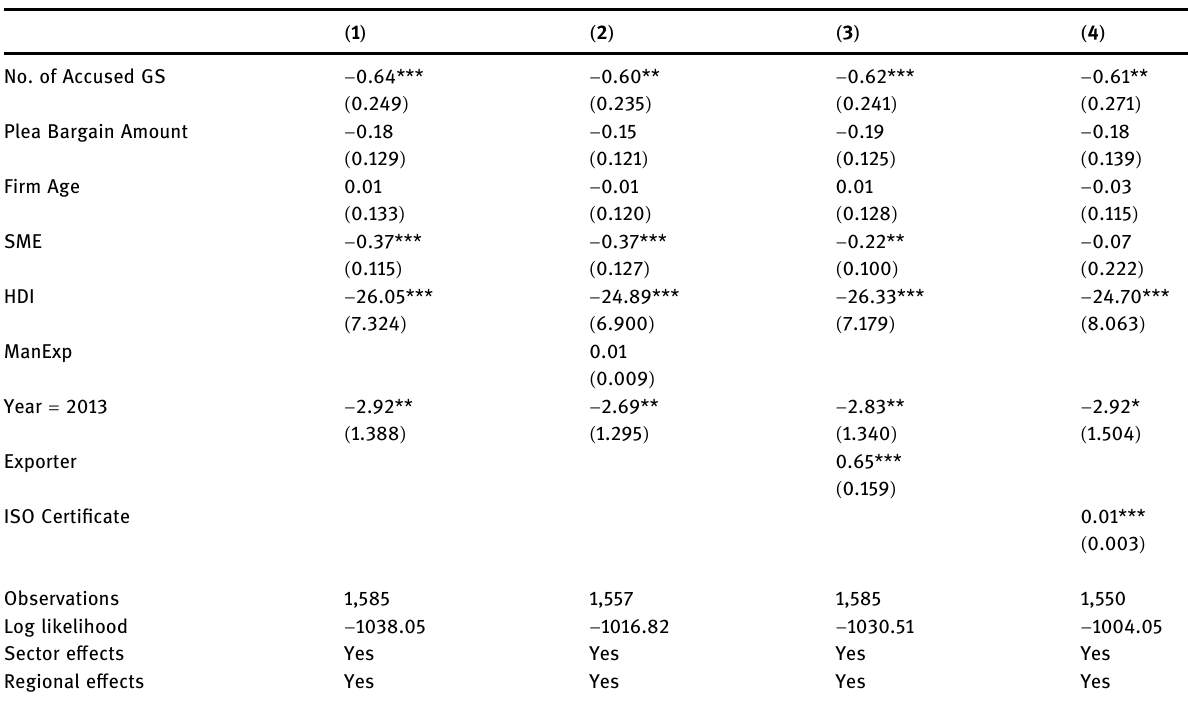
Table 4: Number of corruption accusations and fi rm - level corruption incidence Dep. Variable: Bribe1 ( Firm is expected to pay bribe to government o ffi cials